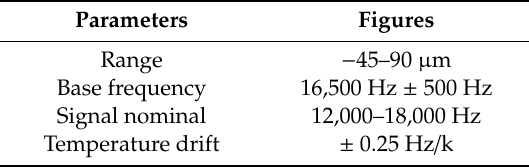
Table 1. The properties of the LoRa strain